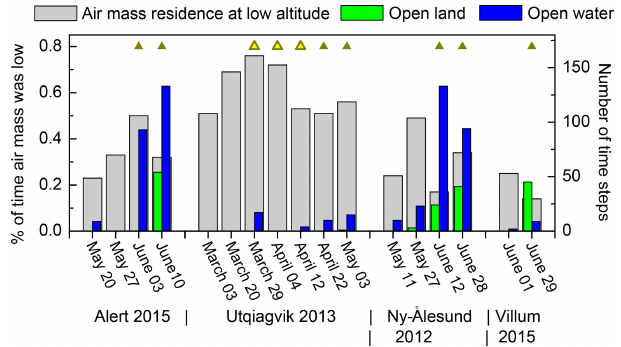
Figure 5. The number of time steps when air masses were at low altitudes and over open land or open water are shown in green and blue, respectively, for different filter samples. The analysis shown was done for altitudes up to 100m for Alert, Ny-Ålesund, and VRS and up to 500m for Utqia˙gvik. Gray bars in the background in- dicate the percentage of time the air masses collected on each fil- ter were below that altitude. Triangles indicate samples for which highly ice-active INPs were detected, i.e., for which INP spectra were measured at high T (single-colored triangles) and at medium T (triangles with yellow interior). The respective INP spectra are shown in Fig.